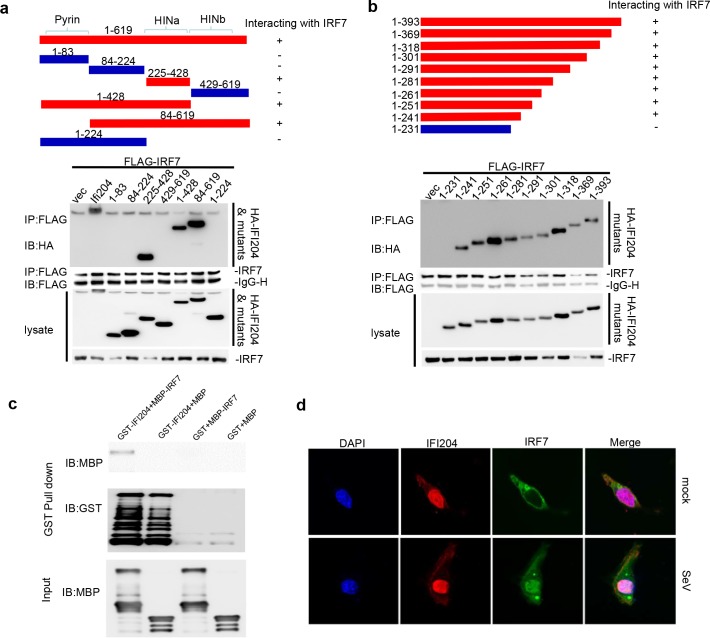
IFI204 interacts with IRF7.(A and B) Schematic diagram to show the regions of IFI204 interacting with IRF7 (upper panels in A and B). Co-immunoprecipitation (IP, with anti-Flag) and immunoblot (IB, with anti-HA) analysis of HEK293T cells that were transfected with plasmids encoding Flag-IRF7 and HA-IFI204 or its mutants. Cell lysate was analyzed by immunoblot with anti-Flag and anti-HA (lower panels in A and B). (C) GST pull-down assay. Purified GST-IFI204 or GST protein was incubated with MBP-IRF7 or MBP as indicated and pulled down with glutathione resin beads. Each sample was detected by Western blotting with the indicated antibodies. GST and MBP proteins were used as a negative control, respectively. (D) Intracellular localization of IFI204 and IRF7 assessed by immunostaining followed by laser scanning confocal microscopy. Irf3−/−Irf7−/−MEFs cells were co-transfected with pFlag-IRF7 and pHA-IFI204 stimulated with SeV for 0 h (mock) and 6 hrs (SeV) at 24 hrs post-transfection. Then cells were washed with PBS and harvested for immunofluorescence analysis. Mouse anti-HA antibody was used as primary antibody and CY3-conjugated goat anti-mouse IgG was used to detect IFI204 as shown in red fluorescence. Rabbit anti-flag antibody was used as primary antibody and FITC-conjugated goat anti-rabbit IgG was used to detect IRF7 as shown in green fluorescence. DAPI (4, 6-diamidino-2-phenylindole) is used for nuclei staining as shown in blue fluorescence. Data are representative of three independent experiments.